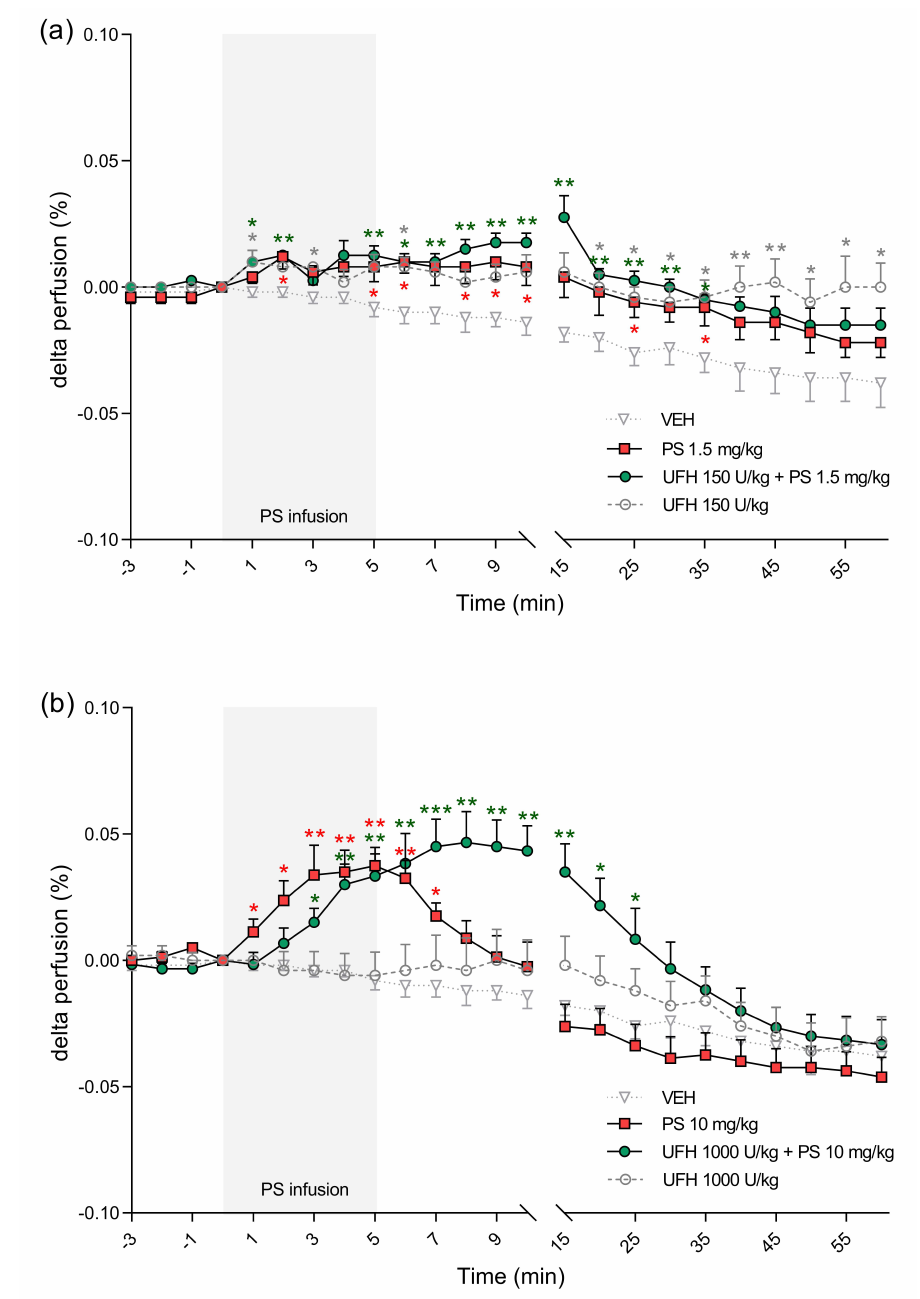
Figure 9. The effects of protamine sulfate (PS) and its complexes with unfractionated heparin (UFH) on perfusion of paw vessels. The course of perfusion of paw vessels was tracked for 60 min after short–duration intravenous infusion (5 min; 2 mL/h) of PS at dose of 1.5 ( a ) or 10 mg/kg ( b ) following intravenous administration of vehicle (VEH, 1 mL/kg) or UFH (150 or 1000 U/kg, 1 mL/kg). Results are shown as means (lines) with SEMs. The perfusion of paw vessels at 0 min of the experiment were 0.08 (0.04–0.14) for VEH, 0.07 (0.05–0.11) for PS 1.5 mg/kg, 0.07 (0.02–0.13) for UFH 150 U/kg + PS 1.5 mg, 0.06 (0.03–0.1) for UFH 150 U/kg, 0.09 (0.05–0.13) for PS 10 mg/kg, 0.1 (0.06–0.14) for UFH 1000 U/kg + PS 10 mg/kg, 0.08 (0.05–0.13) for UFH 1000 U/kg. * p < 0.05, ** p < 0.01, *** p < 0.001 vs. VEH, Kruskal–Wallis ANOVA with Dunn’s post–hoc test, n =